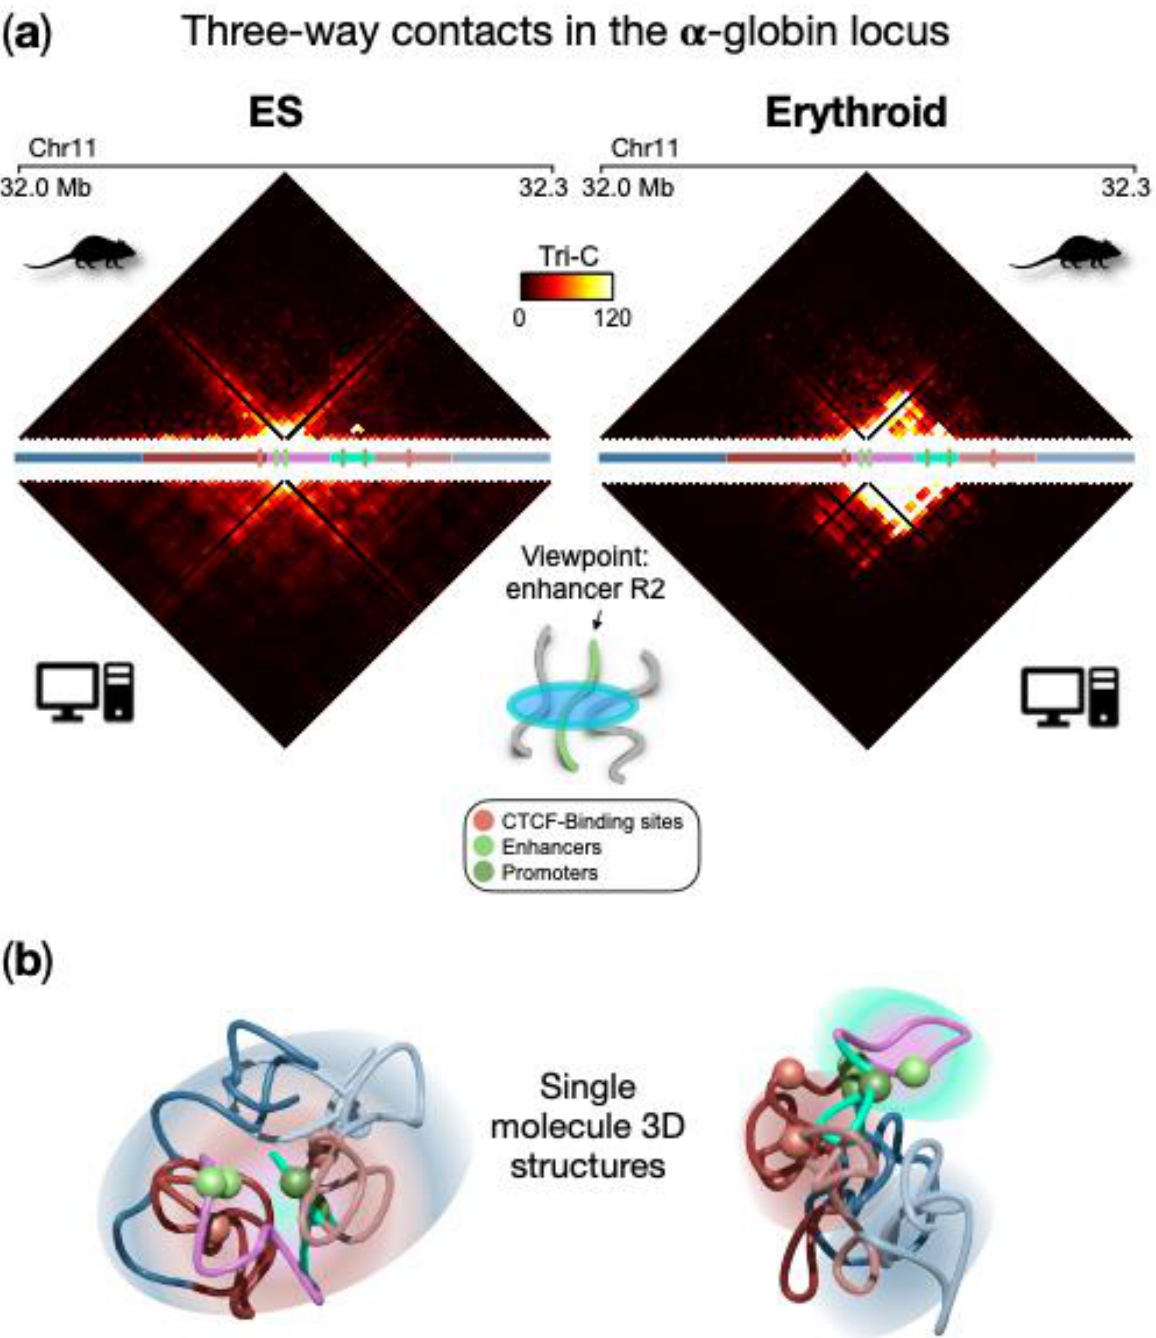
Figure 5. High-multiplicity regulatory contacts at the α -globin locus. ( a ) Three-way contact probabil- ity from the ensemble of polymer conformations in ESCs and erythroid (upper panel) and from the TriC [67] experimental method (bottom panels), with the enhancer R2 as a point of view; ( b ) Example of a single molecule 3D structure obtained from Molecular Dynamics simulations highlights the structural features in ESCs and erythroid cells. Spheres indicate the positions of relevant regulatory elements. Image adapted from